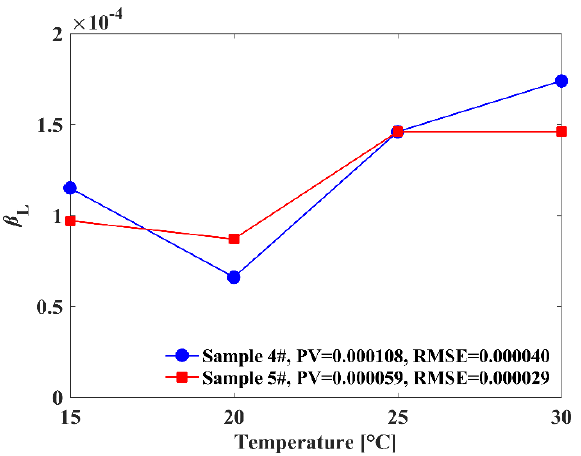
Figure 10. The relationship between β L and temperature for ULE samples with the same CTE.